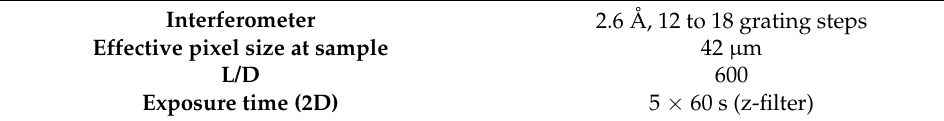
Table 3. Specifications of HFIR CG-1D beamline at ORNL for these experiments.